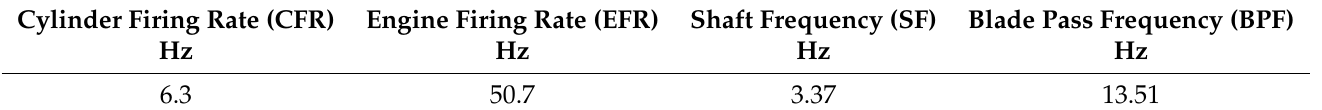
Table 4. The parameters of the ship’s machinery